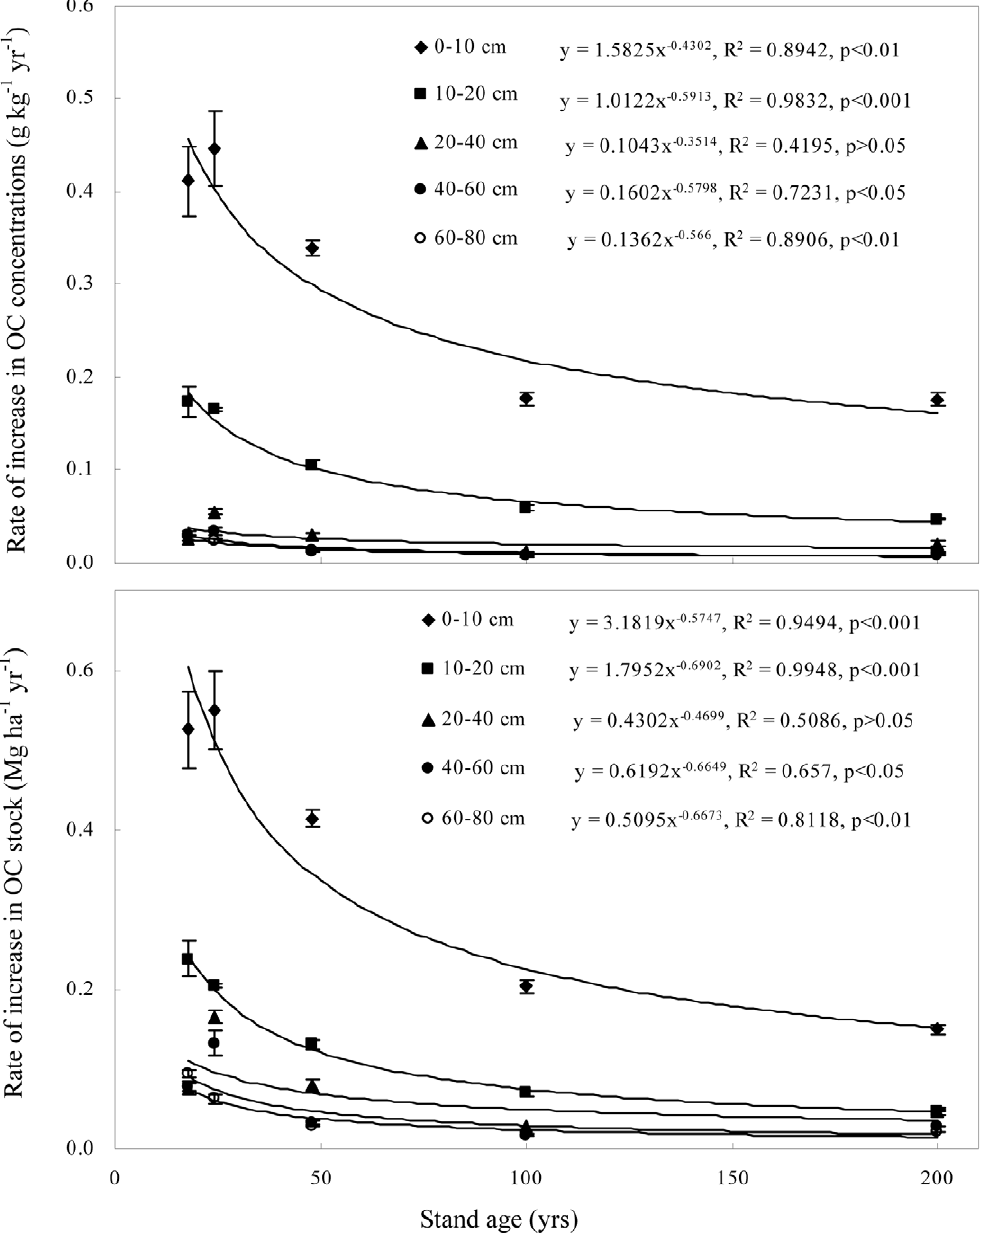
Figure 7. Effect of stand age on the rate of increase in forest-derived OC (the error bars are standard deviation of the means).